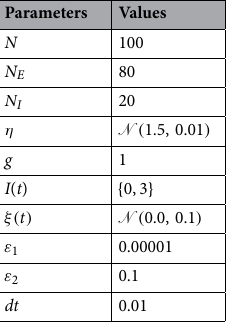
Table 1. Parameters for the network of θ -neurons. .